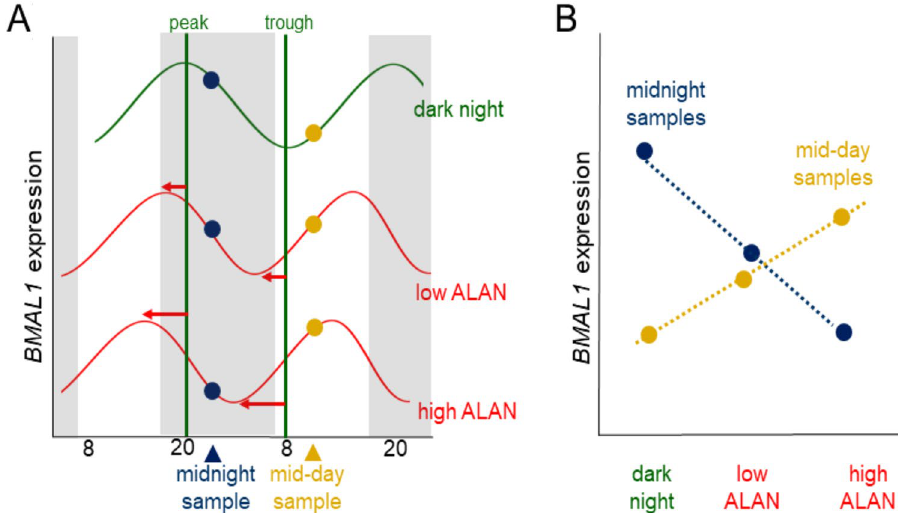
Figure 1. Expected clock gene rhythm advance in response to ALAN. Schematic shows ALAN effects on transcript levels of BMAL1 measured at midnight (blue) and mid-day (yellow). ( A ) Rhythm of ALAN under dark night shown as green curve; if the gene’s rhythm advances (red curves) with increasing ALAN, transcript levels sampled at midnight will drop, whereas those measured at mid-day will rise; horizontal arrows